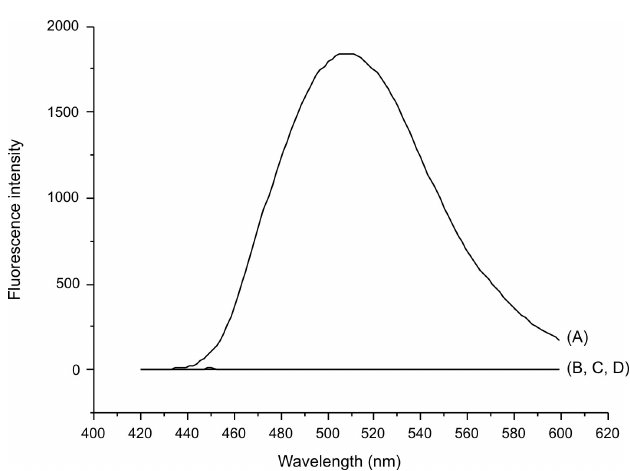
FIGURE 2 - Emission spectra obtained for: (A) curcumin standard solution, 1 m g/mL; (B,C,D) unloaded polymeric nanocapsule suspensions prepared using Pluronic F 68,